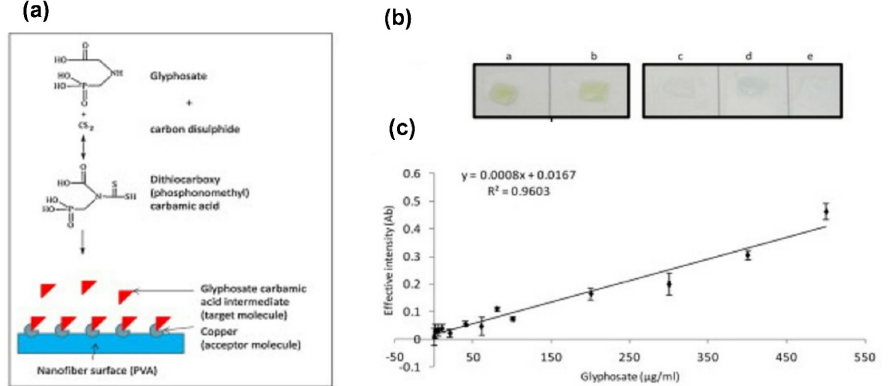
Figure 20. ( a ) The schematic representation of the cd-PVA sensor system. ( b ) The visual colorimetric response of the cd-PVA sensor strips immediately after the addition of 1000 µg/mL of the pure glyphosate derivative (99.5%) a and b: cd-PVA sensor strips after the addition of the glyphosate sample (volume: 30 µL). Values are grap hically presented as mean values ± SD (n = 2). Control re- actions included: c: no glyphosate, d: no carbon disulfide, e: a no test sensor strip/blank. ( c ) The calibration curve for glyphosate (0.1–500µg/mL). The sample volume was 30 µL and the appropriate c ontrols were used in this study. Values are presented as mean values ±SD (n= 3). Adapted with permission from [165]. Copyright 2015 Elsevier.